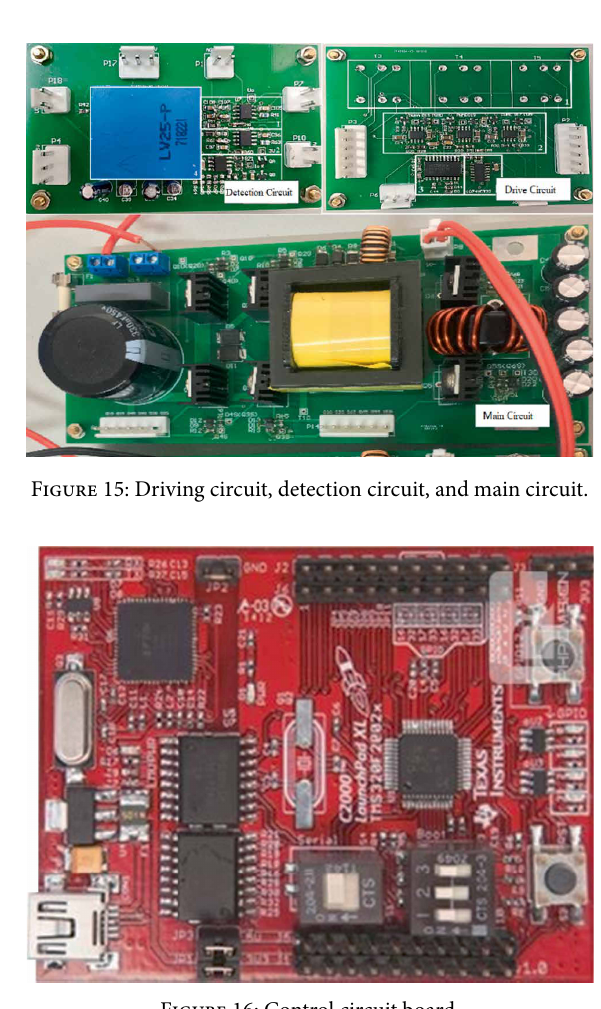
Figure 14: Output voltage sampling circuit.